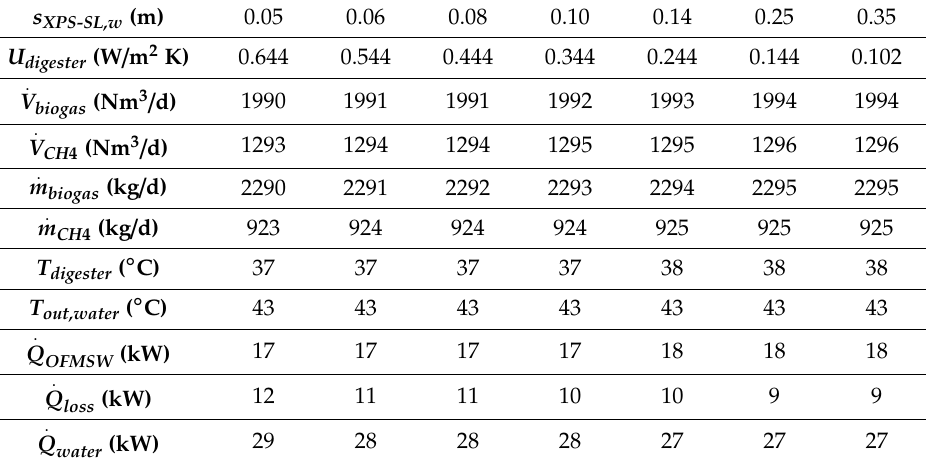
Figure 9. Thermal flow rates . m water = 0.557 kg / s and T in,water = 55 ◦ C. Table 10. Variation in model results due by varying walls‘ insulation thickness. s XPS-SL,w (m) 0.05